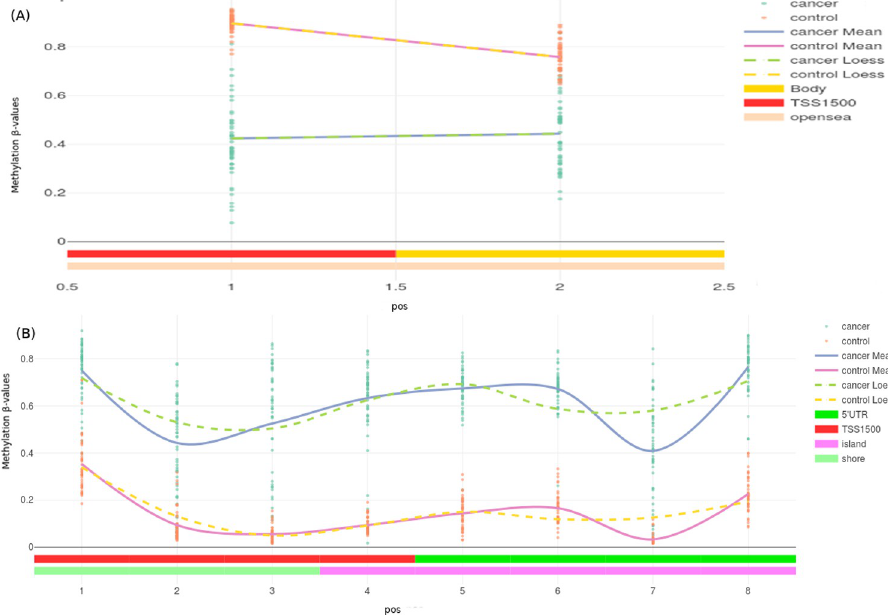
Fig 5. DMP and DMR plots using ChAMP. (A) DMP plot of FCN2 for stage-I vs control illustrating significant hypomethylation (B) DMR plot of transcriptional activator EYA4 for stage-I vs control illustrating significant hypermethylation. Solid lines represent mean values while dashed lines represent the